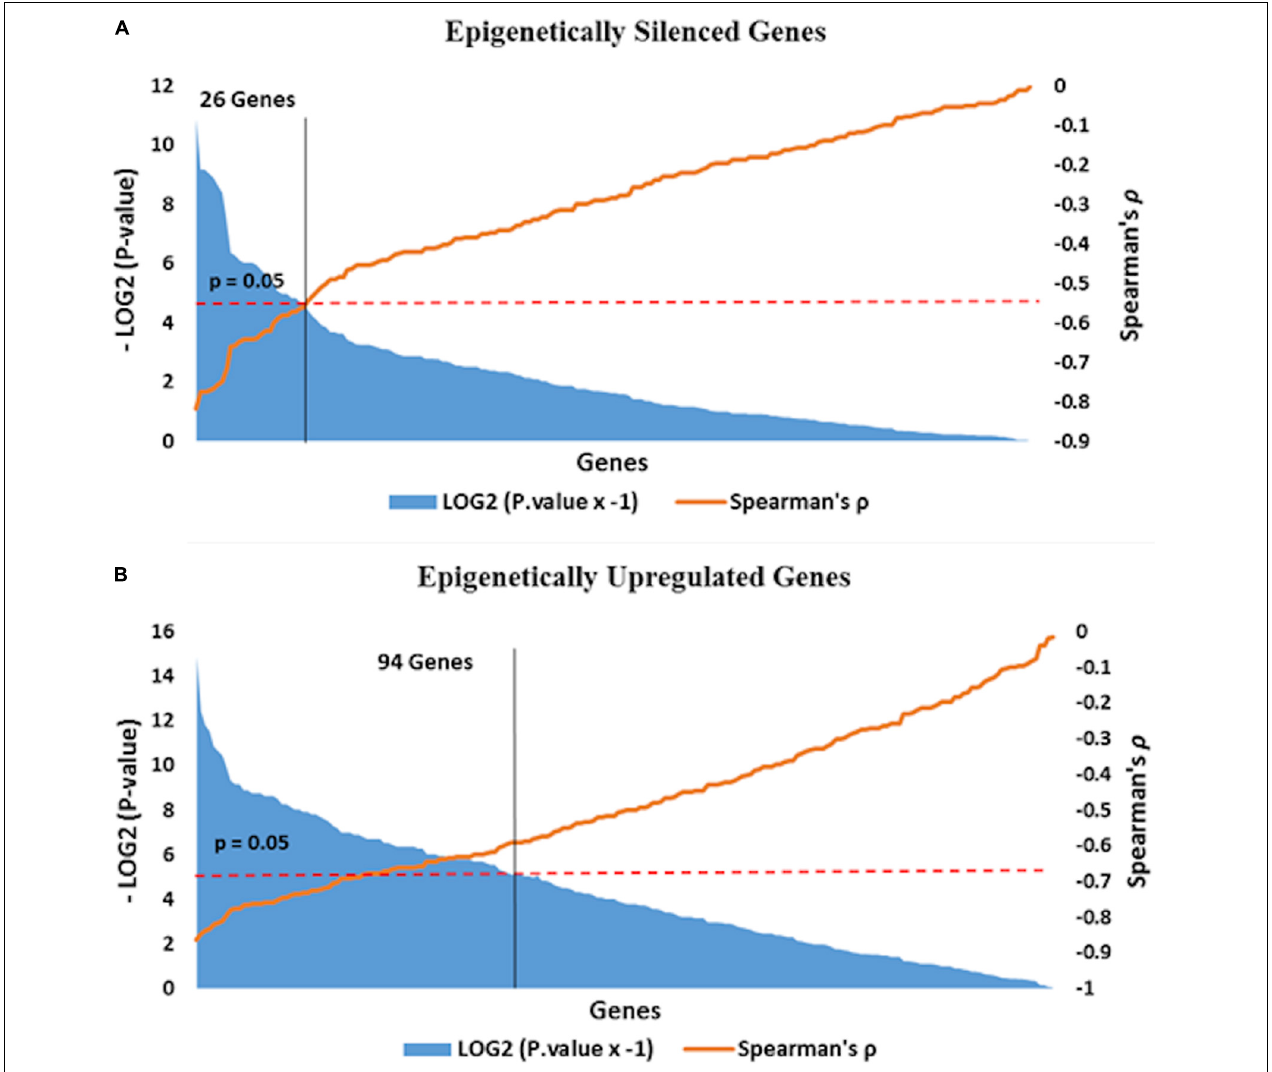
FIGURE 5 | Epigenetically (A) silenced and (B) overexpressed genes are distributed along the X -axis according to Spearman’s correlation value in the ascending order. Negative correlation value represents the opposite direction of β value and log2 fold change expression values. Correlation test P value threshold ( > 0.05, red line in the plot) demarcates genes (yellow line in plot) with statistically correlated promoter methylation driven